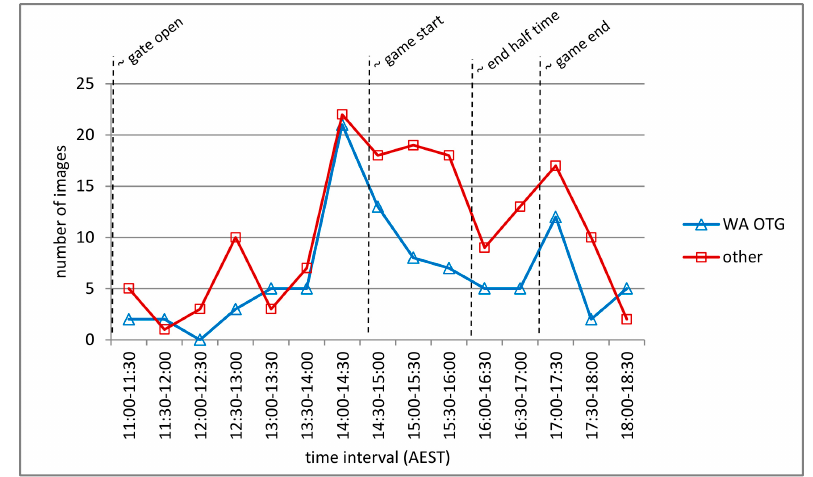
Figure 4. A comparison of posting time for images categorized as WA OTG vs. all other categories for the ADon dataset.